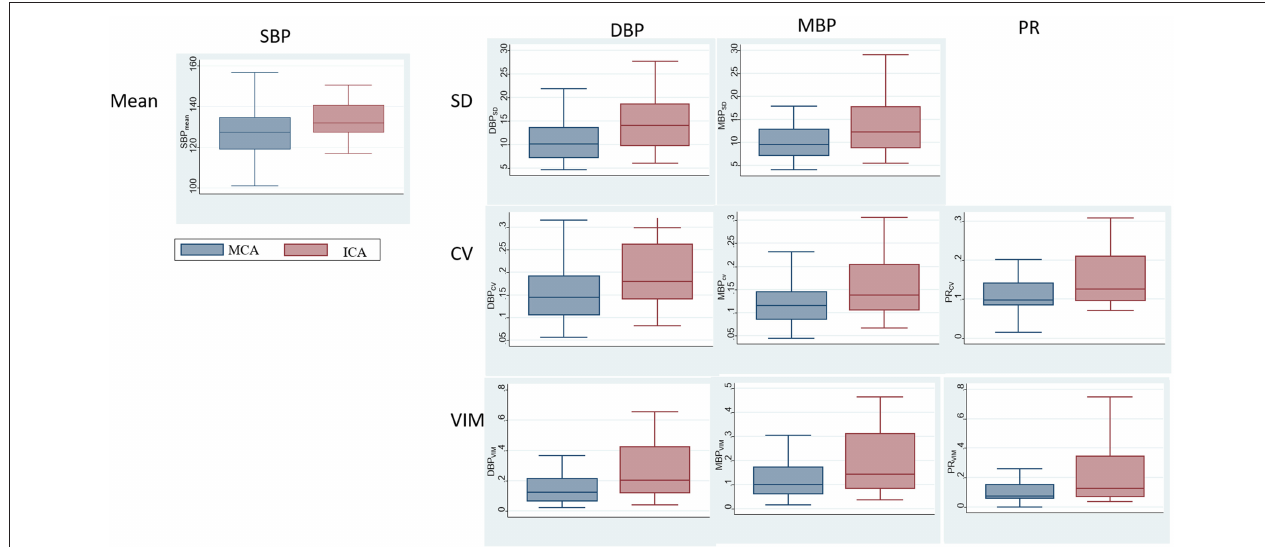
FIGURE 1 | Comparison of blood pressure variability (BPV) parameters according to the occlusion sites.